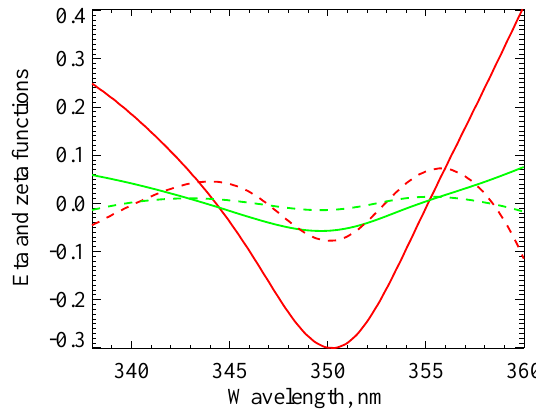
Fig. 2. Logarithms of eta (red) and zeta (green) functions with linear polynomial subtracted shown by solid lines and with cubic polyno- mials subtracted shown by dashed